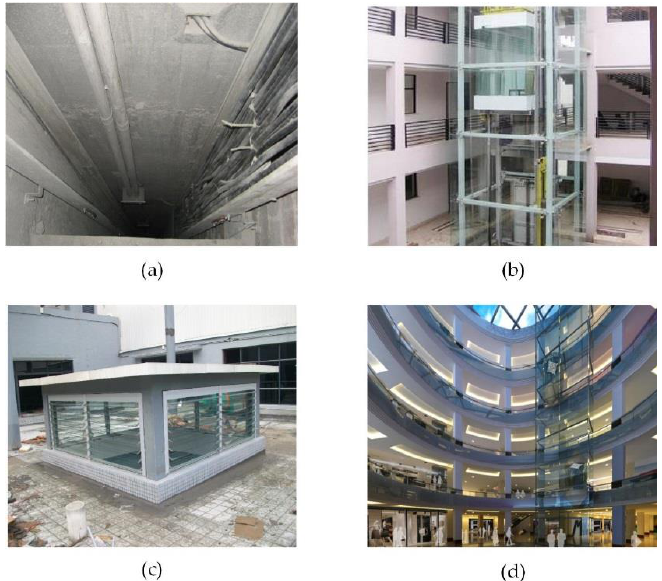
Figure 8. Examples of cross-floor spaces: ( a ) pipe well, ( b ) elevator shaft, ( c ) air duct well, and ( d ) atrium.